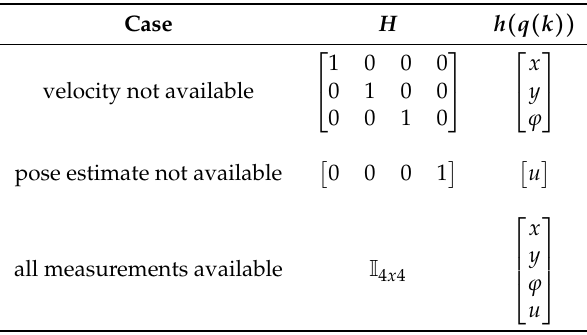
Table 1. Some possible observation model